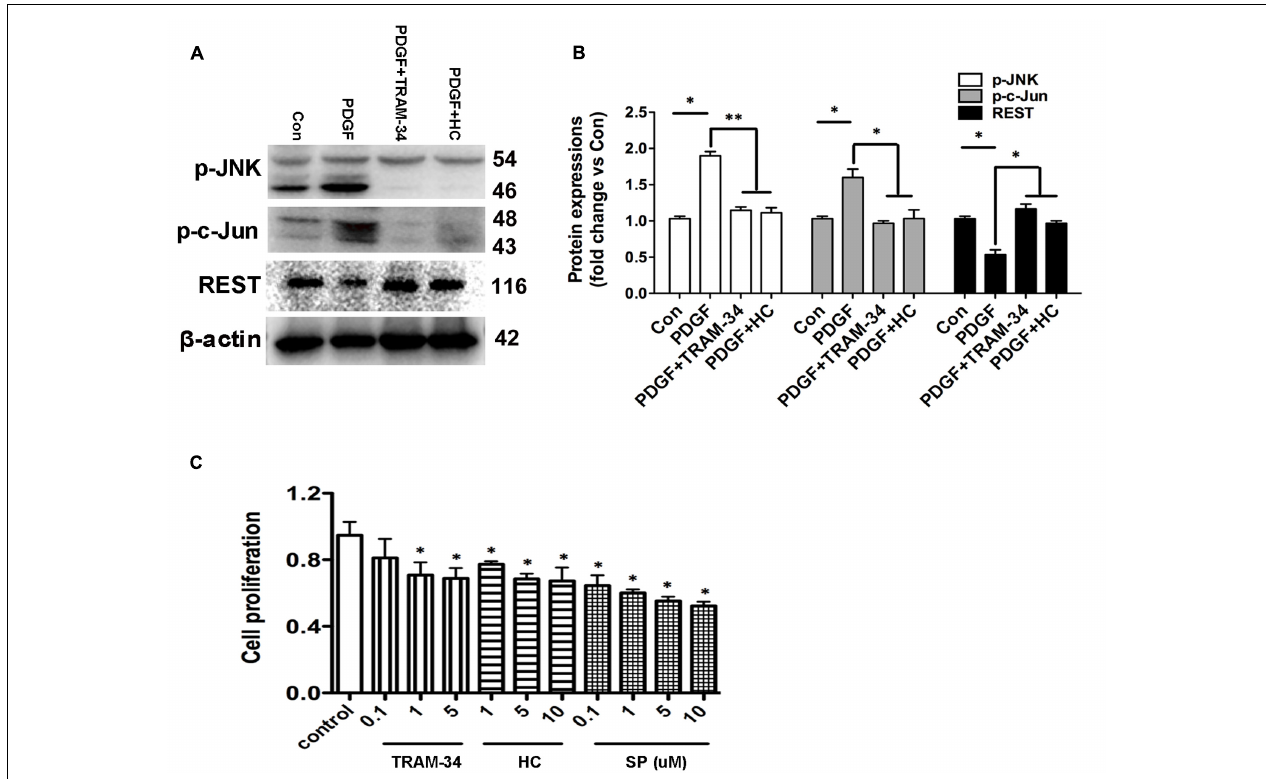
FIGURE 9 | KCa3.1 and TRPV4 involvement in HBSM cells proliferation via JNK/c-Jun pathways. (A) p-JNK, p-c-Jun, and REST protein expressions in 1h PDGF stimulated HBSM cells with or without pretreatment of TRAM-34 (1 µ M) or HC 067047 (10 µ M). (B) Data were presented as means ± SEM. n = 5, ∗ p < 0.05, ∗∗ p < 0.01, one-way ANOVA followed by the Dunnett’s multiple comparison test compared with PDGF. Con, control; HC, HC 067047. (C) Analysis of HBSM cells proliferation treated with TRAM-34, HC 067047, or SP600125. Cells treated for 72 h with or without TRAM-34 (0.1–5 µ M), HC 067047 (1–10 µ M), or SP600125 (0.1–10 µ M) in culture medium. Cell proliferation (CCK-8 assay) was then measured as described in methods. After treating cells with serum-free medium for 24 h, proliferation was induced by 10% FBS in the absence or presence of TRAM-34 (0.1–5 µ M), HC 067047 (1–10 µ M), or SP600125 (0.1–10 µ M) for 72 h, and then assayed by measuring CCK-8 at the indicated times ( n = 4). Values were reported as means ± SEM normalized to the control. ∗ p < 0.05, one-way ANOVA followed by the Dunnett’s multiple comparison test compared with control. HC, HC 067047; SP,